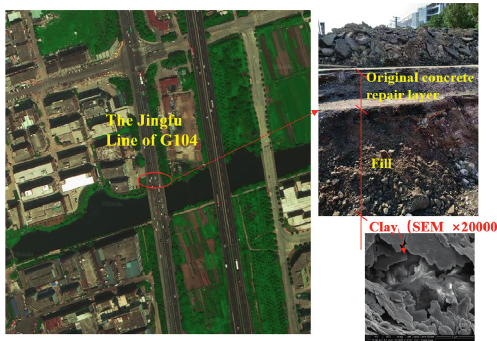
Figure 1: Original foundation excavation diagram of the bridge end